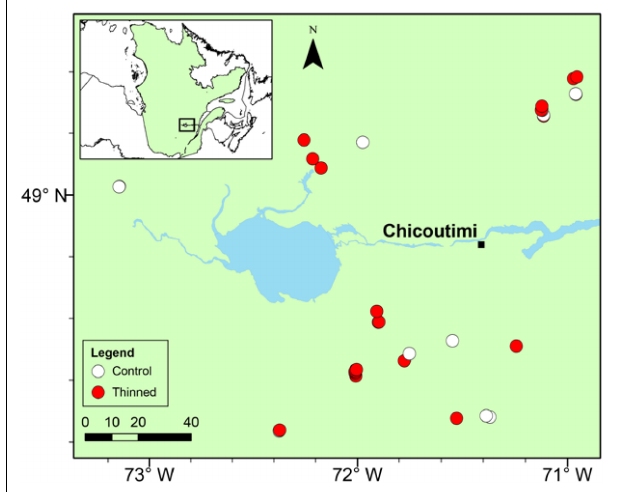
FIGURE 1 | Location of the study stands in the Saguenay-Lac-Saint-Jean region. White and red dots correspond to control and thinned stands,